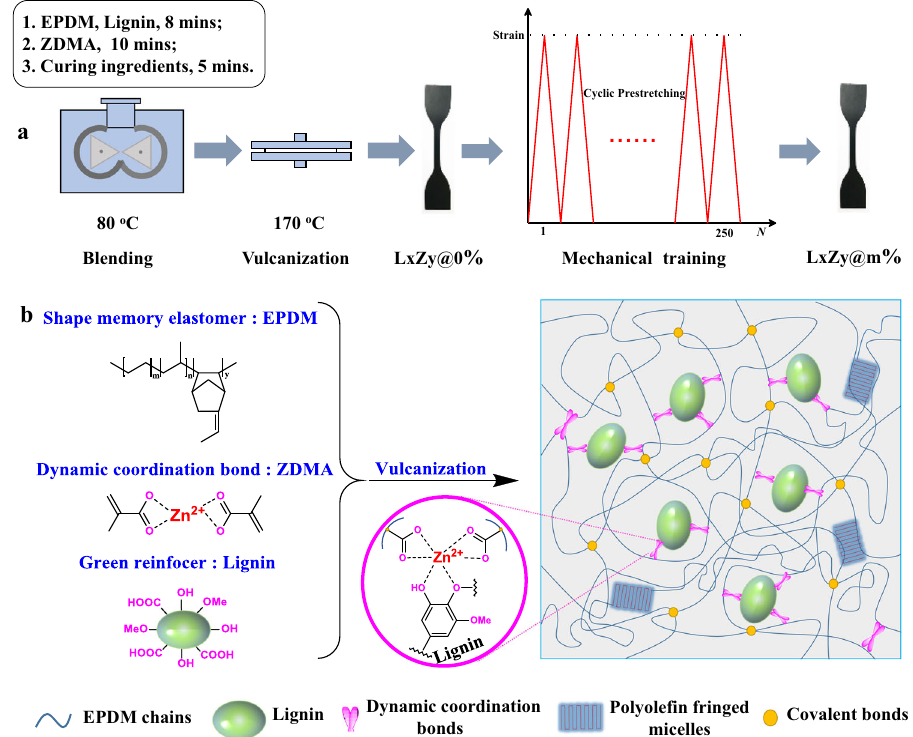
Fig. 1 The preparation schematic diagram and mechanical perfomance of arti fi cial muscle materials. a Preparation diagram of EPDM-based arti fi cial muscle materials. b Schematic illustration for the interfacial coordination bonds in the EPDM composite.